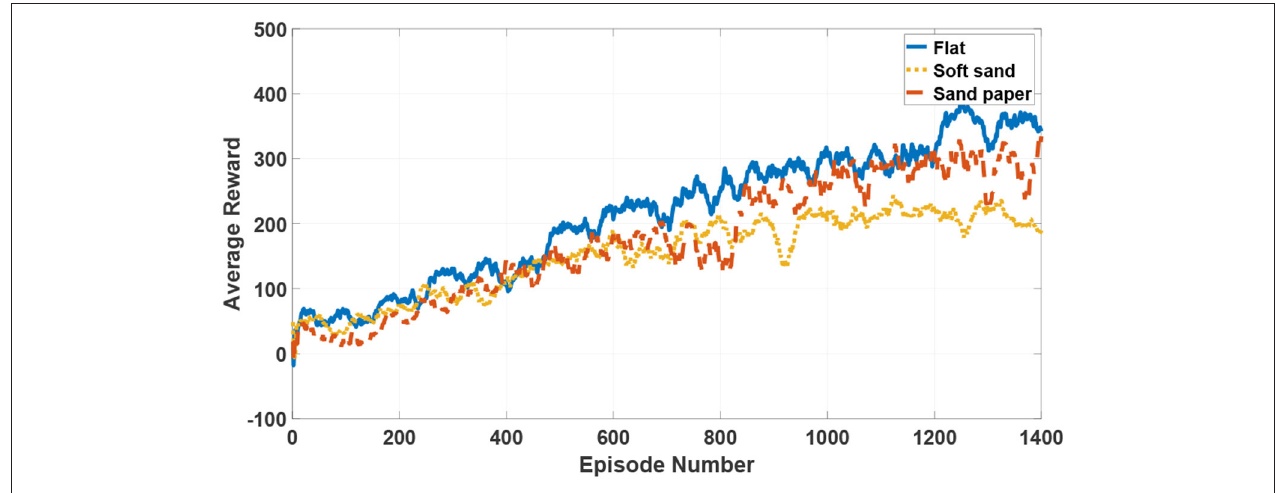
FIGURE 10 | The average reward of reinforcement learning in the tripod locomotion.